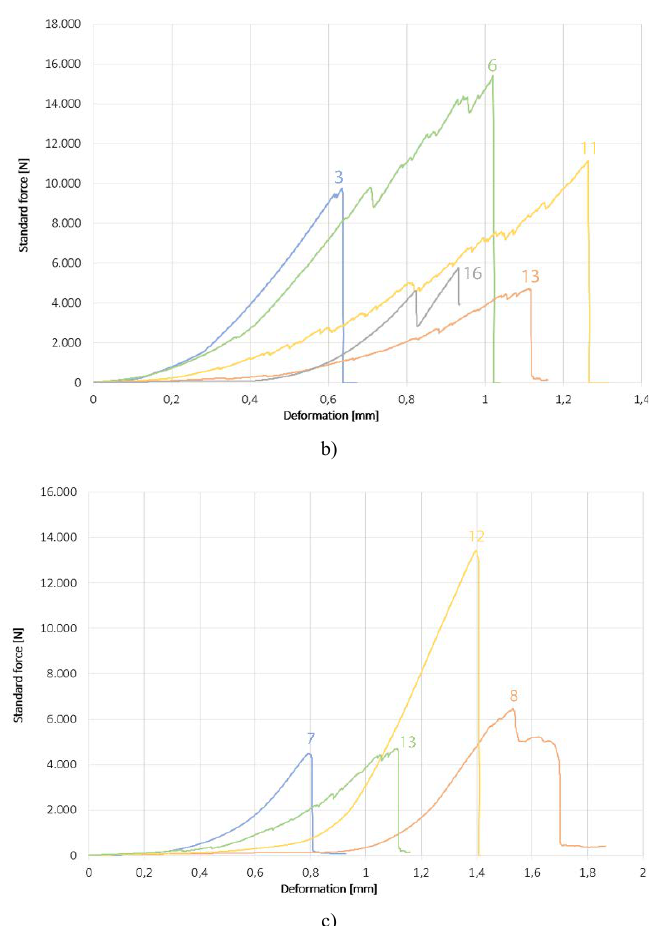
Figure 8. Force-displacement diagram of specimens with: a) the first force trend; b) the second force trend; c) the third force